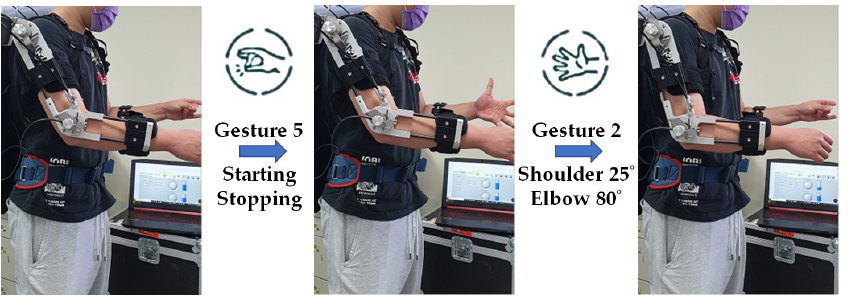
Figure 33. Desired action experiment with a shoulder flexion angle of 25° and an elbow flexion angle of 80°.